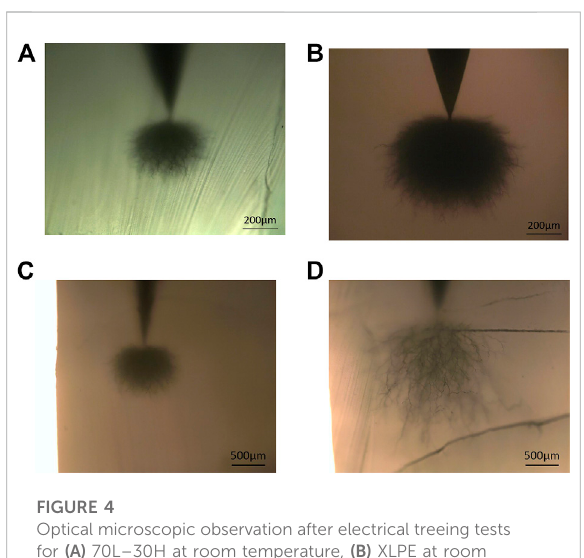
FIGURE 4 Optical microscopic observation after electrical treeing